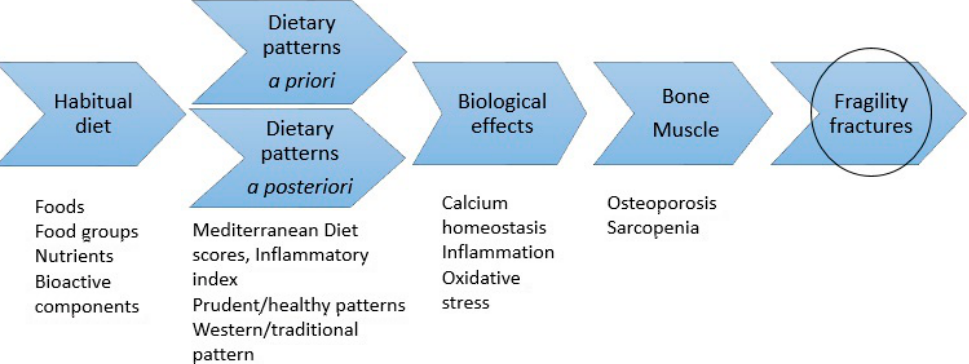
Figure 1. Schematic representation of the theme of the current review; association between diet and fragility fractures. Information on habitual diet is used to create dietary patterns. The dietary patterns are theoretical reflections of the food matrix. The food matrix contains nutrients and other bioactive components necessary for the maintenance of bone and muscle strength and function, thus influencing fragility fracture risk. In light of the literature, the absence of a healthy diet appears to be related to an increased risk of fragility fractures ..